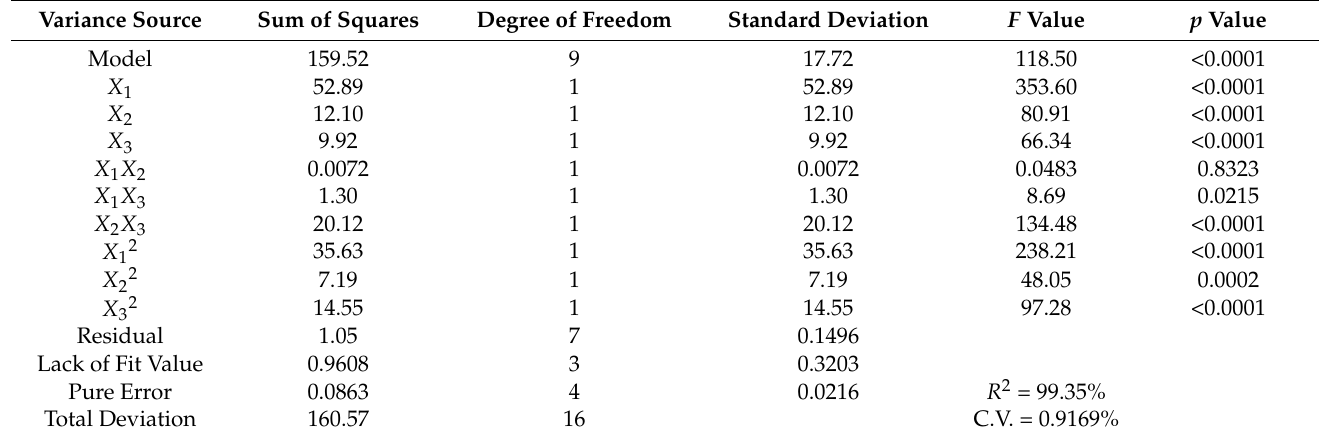
Table 14. Variance analysis of response surface regression